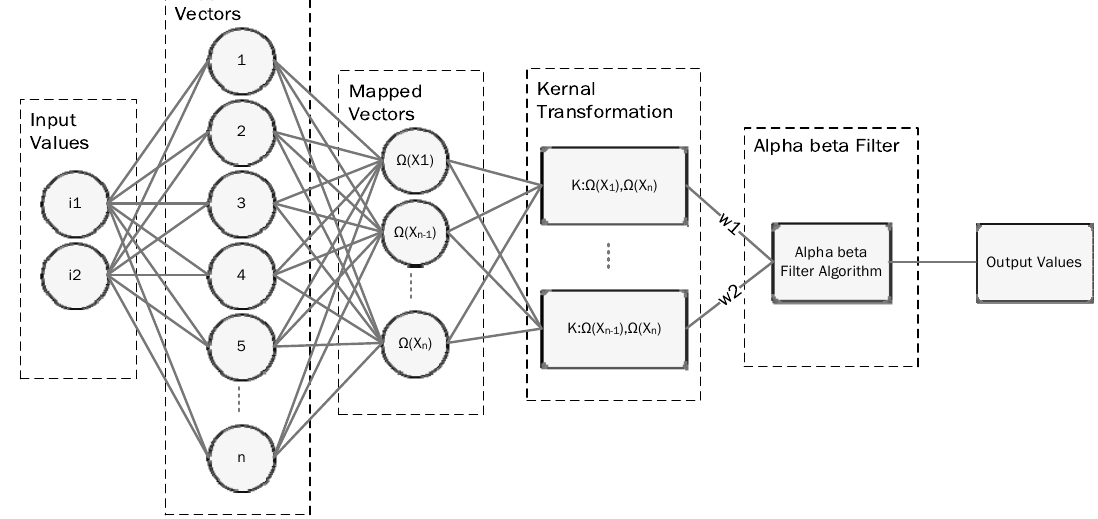
Figure 5. The structure of the proposed SVM-based alpha-beta filter.